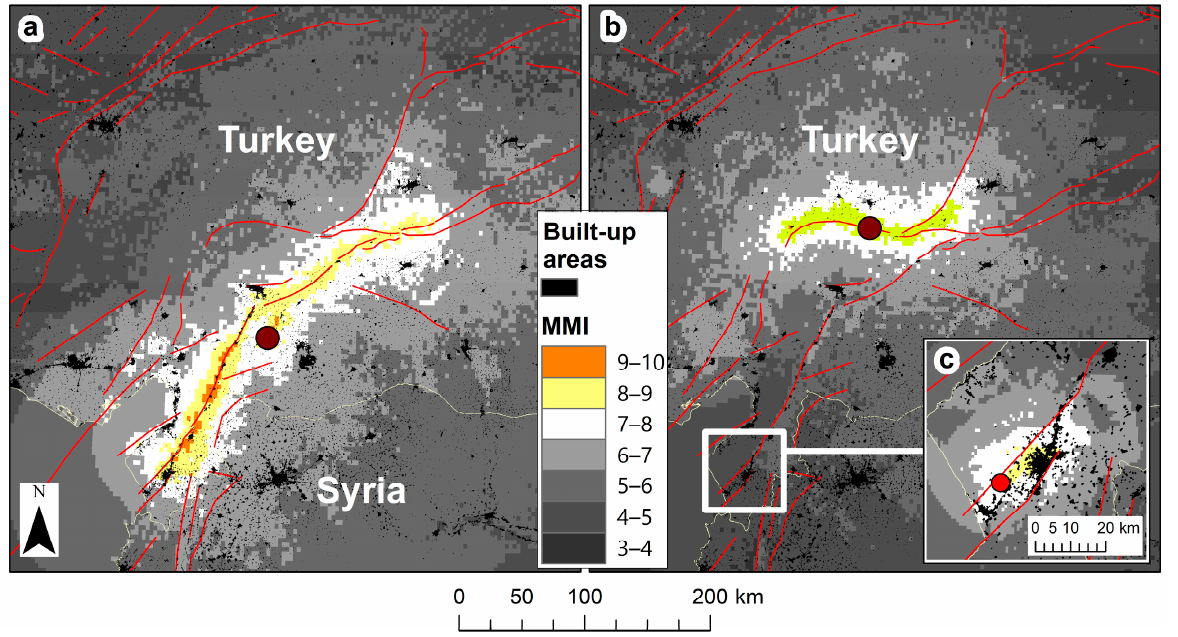
Figure 1. Shake maps of macroseismic intensity (we will hereafter refer to macroseismic intensity as “MMI” for Modified Mercalli Intensity) of three major earthquakes: ( a ) 7.8 magnitude earthquake, 6 February 2023; ( b ) 7.5 magnitude earthquake, 6 February 2023; ( c ) 6.3 magnitude earthquake, 20 February 2023. All maps show the location of their respective epicenter, and are overlaid by major fault lines and built areas from the global human settlements layer. The three administrative areas that were most impacted in terms of the number of VIIRS lit grid cells with statistically significant decreases in NTL were Antakya (Hatay- Merkez) (n = 1323), Hatay-Kirkhan (n = 223) and K. Maras (n = 163). The three admin- istrative areas that were most impacted in terms of the percentage of VIIRS lit grid cells with statistically significant decreases in NTL were Antakya (Hatay-Merkez) (63% of all lit grid cells), Hatay-Samanda (43%) and Hatay-Kirkhan (29%). Decreases in NTL de- tected by VIIRS matched well with areas in which NTL decreases were mapped using the higher-spatial-resolution images of SDGSAT-1 (Figure 6), and were significantly correlated (r = 0.70, n = 1228 for the VIIRS lit grid cells of Antakya; Figure